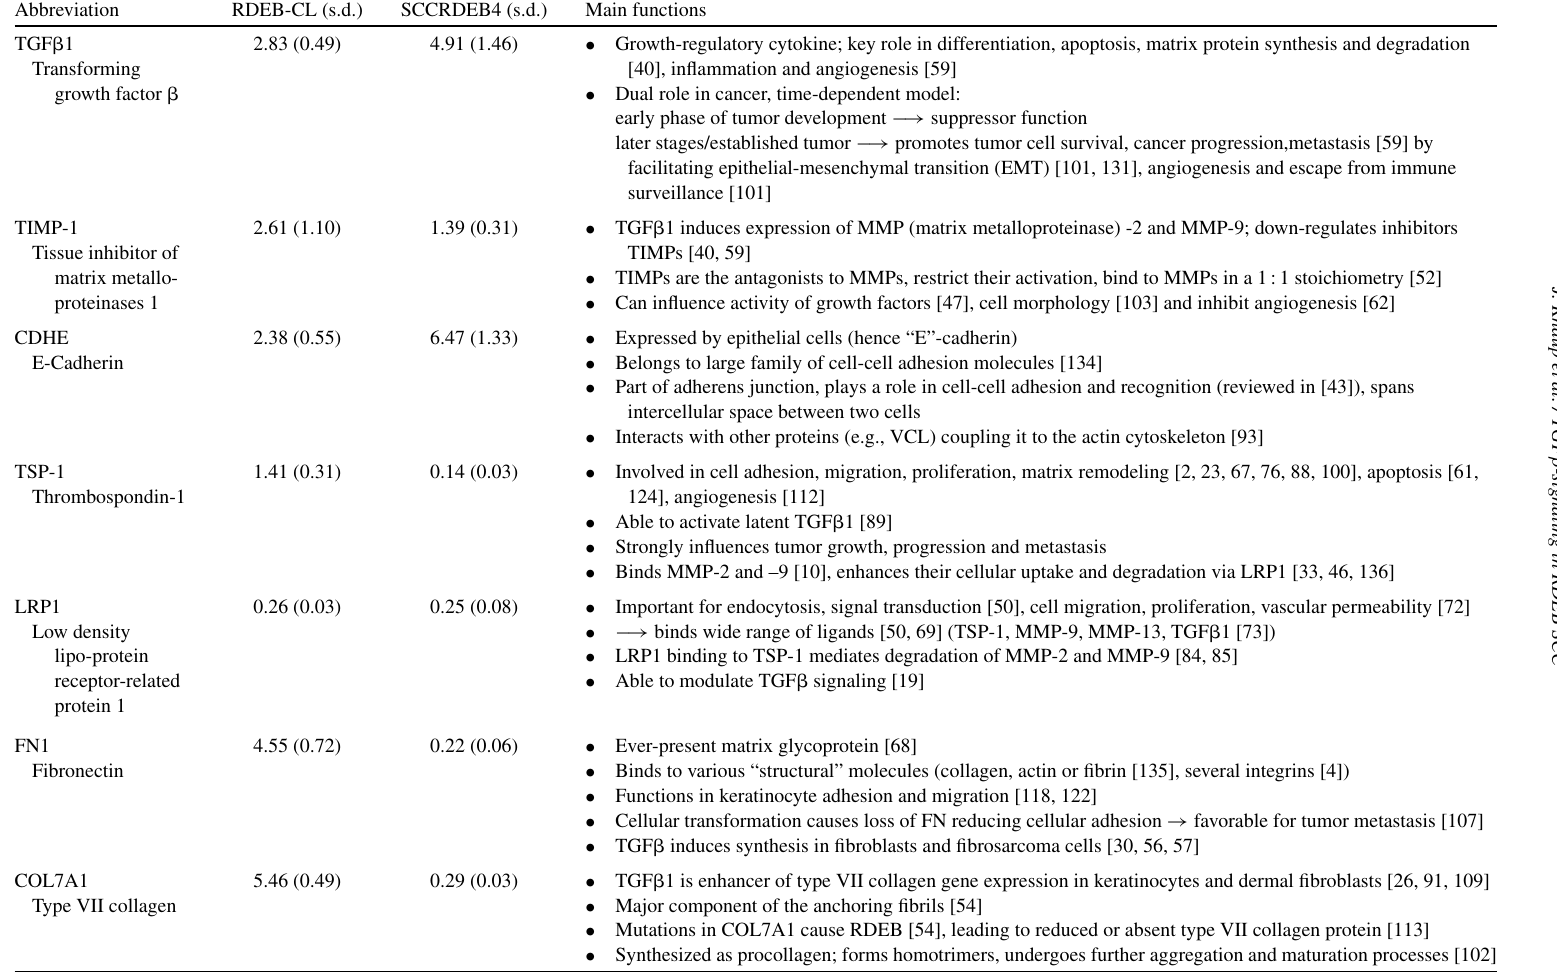
Real time RT-PCR results (expression ratio vs. HaCaT cells) and main